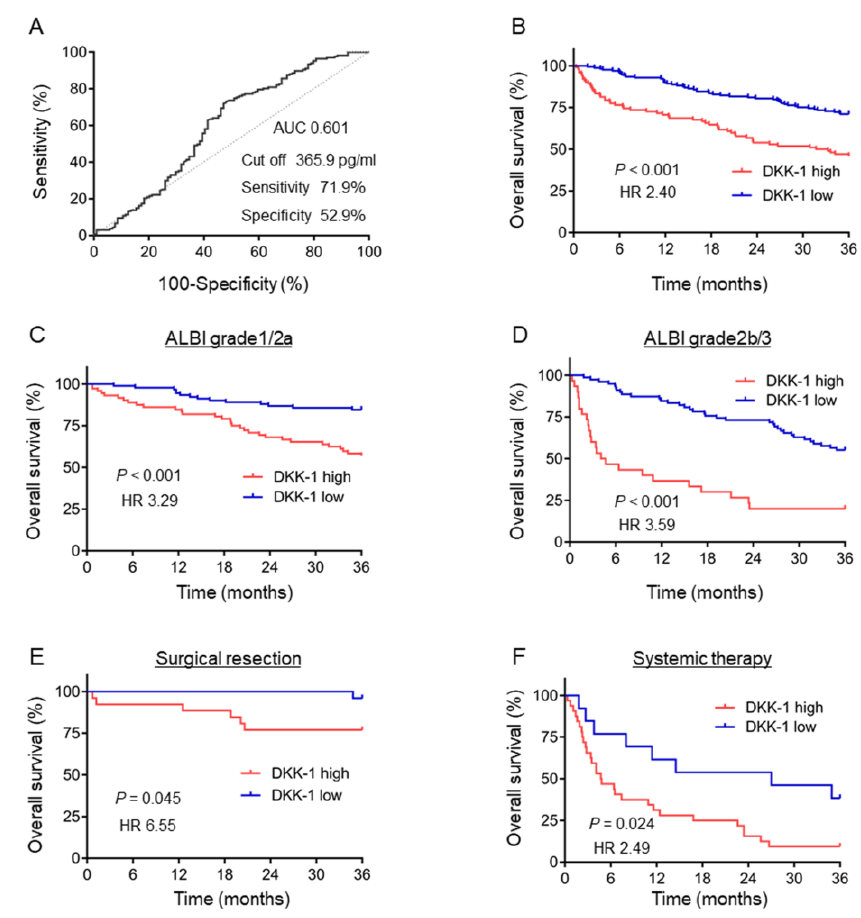
Figure 4. Overall (3-year) survival. ( A ) The receiver operating characteristic (ROC) curve analysis for survival showing the cutoff value of serum Dickkopf-1 (DKK-1) levels to be 365.9 pg/mL; area under the ROC curve (AUC) is 0.601, sensitivity is 71.9%, and specificity is 52.9%. ( B ) Kaplan–Meier survival analysis, indicating statistically significant correlation of elevated serum DKK-1 levels (≥365.9 pg /mL) with worse prognosis ( p < 0.001). ( C , D ) In both albumin-bilirubin (ALBI) grade 1/2a (good liver function) and 2b/3 (poor liver function) cohorts, the high-serum DKK-1 group showed a statistically significant worse prognosis ( p < 0.001). ( E , F ) The prognosis was significantly worse in patients with elevated DKK-1 levels in early stages treated by surgical resection ( p = 0.045) as well as in those in an advanced stage treated by systemic therapy ( p = 0.024).